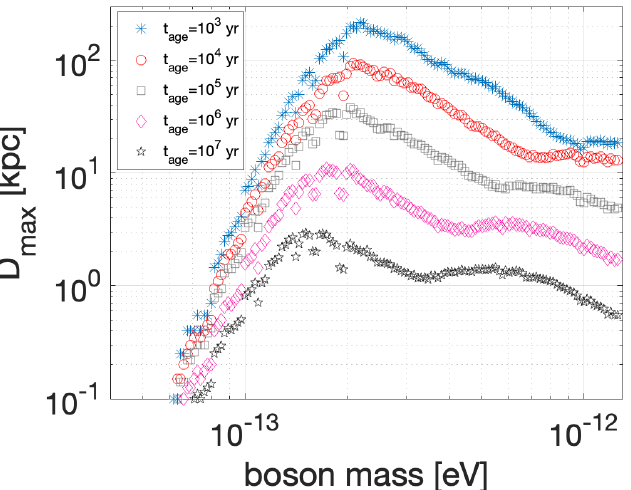
Figure 6. Maximum distance at which at least 5% of a simulated population of BHs-boson cloud would produce a detectable GW signal in the search described in [297]. The simulated population has a maximum BH mass of 100 M . The curve is produced for different markers for systems with (cid:12) ages between 10 3 yrs and 10 7 yrs, as indicated in the legend. Figure taken from